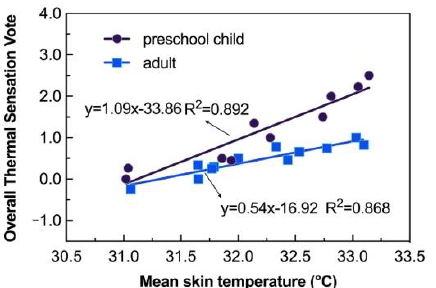
Figure 10. Changes in the OTSV with mean skin